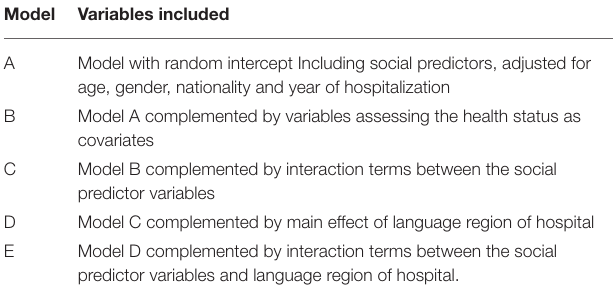
TABLE 2 | Overview of the multilevel logistic regression model building process. Model Variables